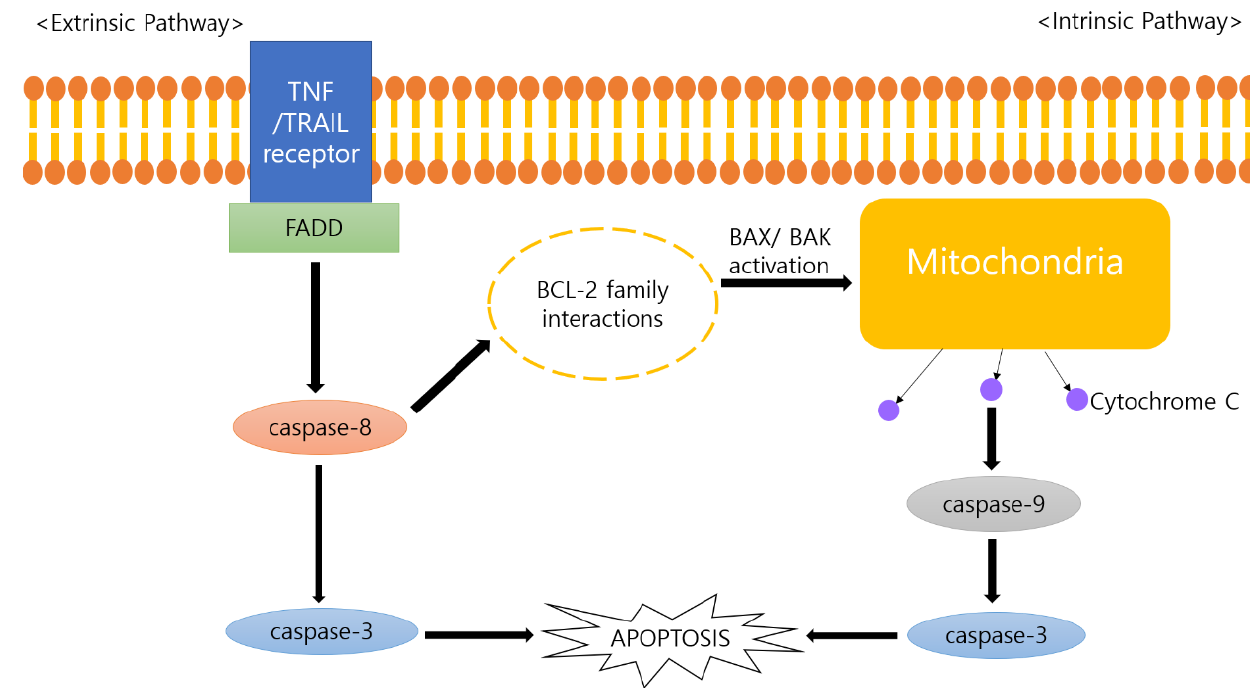
Figure 1. Schematic diagram of intrinsic and extrinsic apoptosis pathways. TNF, tumor necrosis factor; TRAIL, TNF-related apoptosis-inducing ligand; FADD, Fas-associated death domain; BCL-2, B-cell lymphoma 2; BAX, Bcl-2-associated X protein; BAK, Bcl-2 homologous antagonist killer.